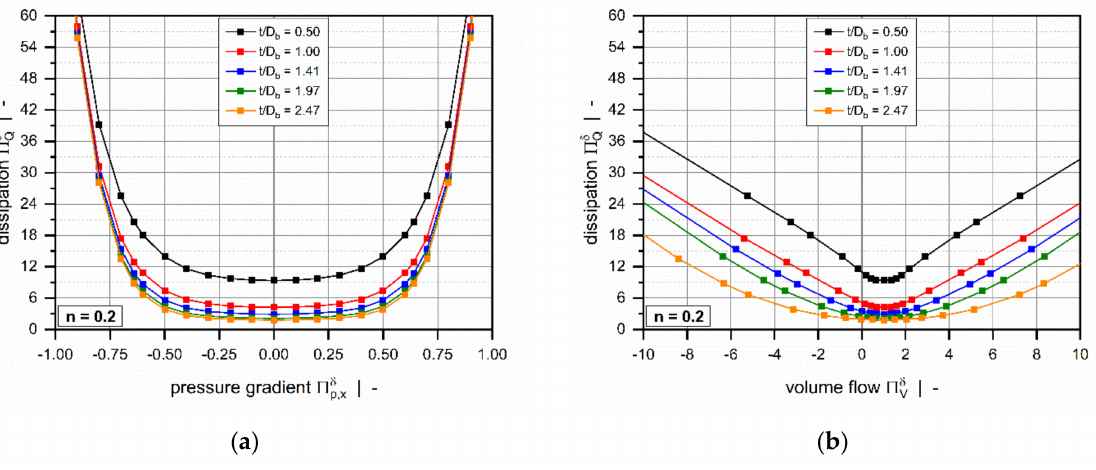
Figure 8. Dimensionless dissipation Π δ the dimensionless volume flow rate Π δ n = 0.2 .